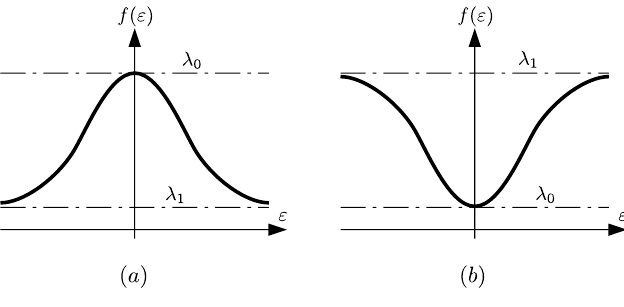
Figure 1. Gaussian function when ( a ) λ 1 < λ 0 ( b ) λ 1 > λ 0